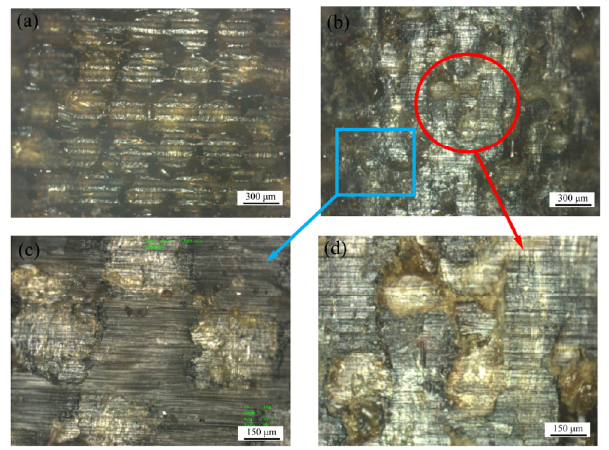
Fig. 10 The worn surface morphology of the fabric liner: (a) before wearing out, (b) after swinging 25,000 times, (c) the region closed to the end of the bearing, and (d) the middle contact region in the width direction.